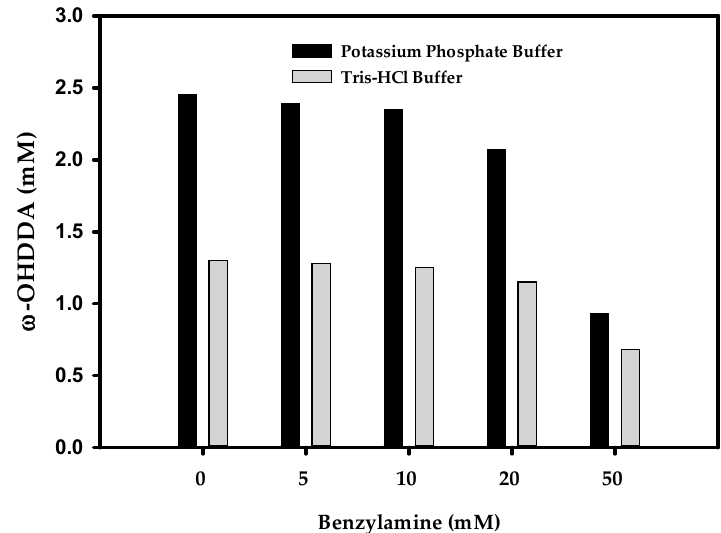
Figure 5. Effect of BA on ω -OHDDA productivity. Reaction conditions: substrate concentration: 10 mM; volume: 10 mL in 100 mL flask; temperature: 35 °C; cell type: BW25113 ( Δ fadD, DE3) containing pA13-BM3R; cell OD 600 : 30 and buffer, 100 mM (pH 7.5) with 1% (w/v) glucose; reaction time: 5 h .